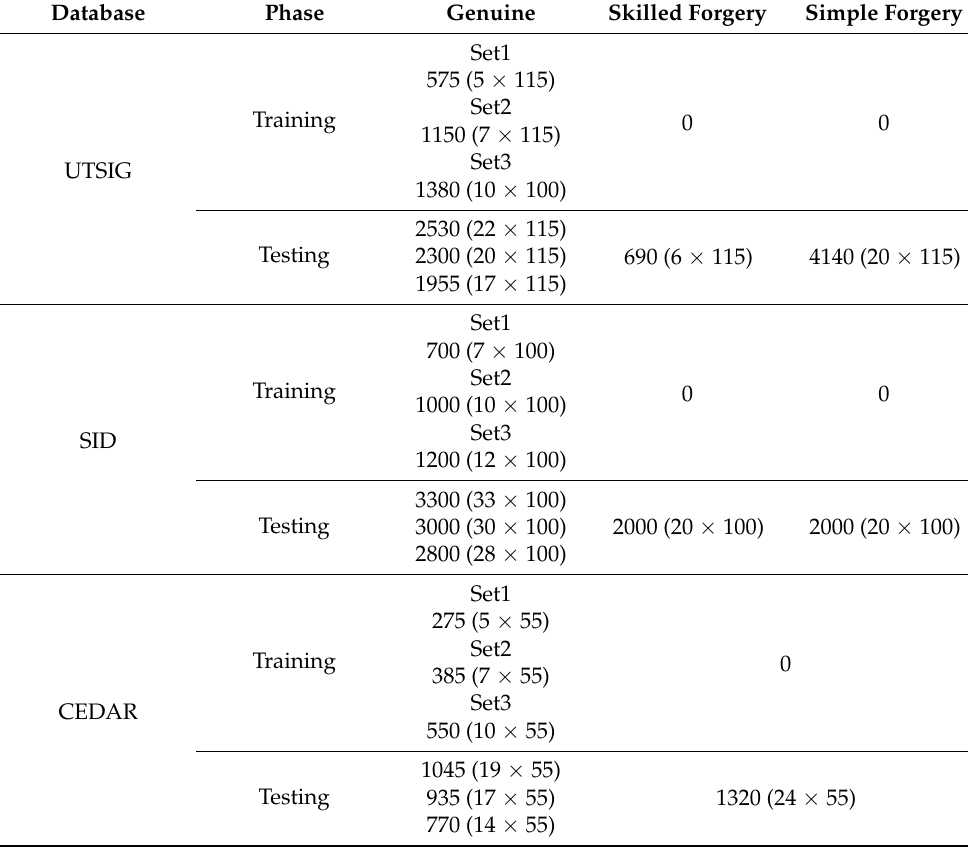
Table 5. Division of database samples for modeling assessment.